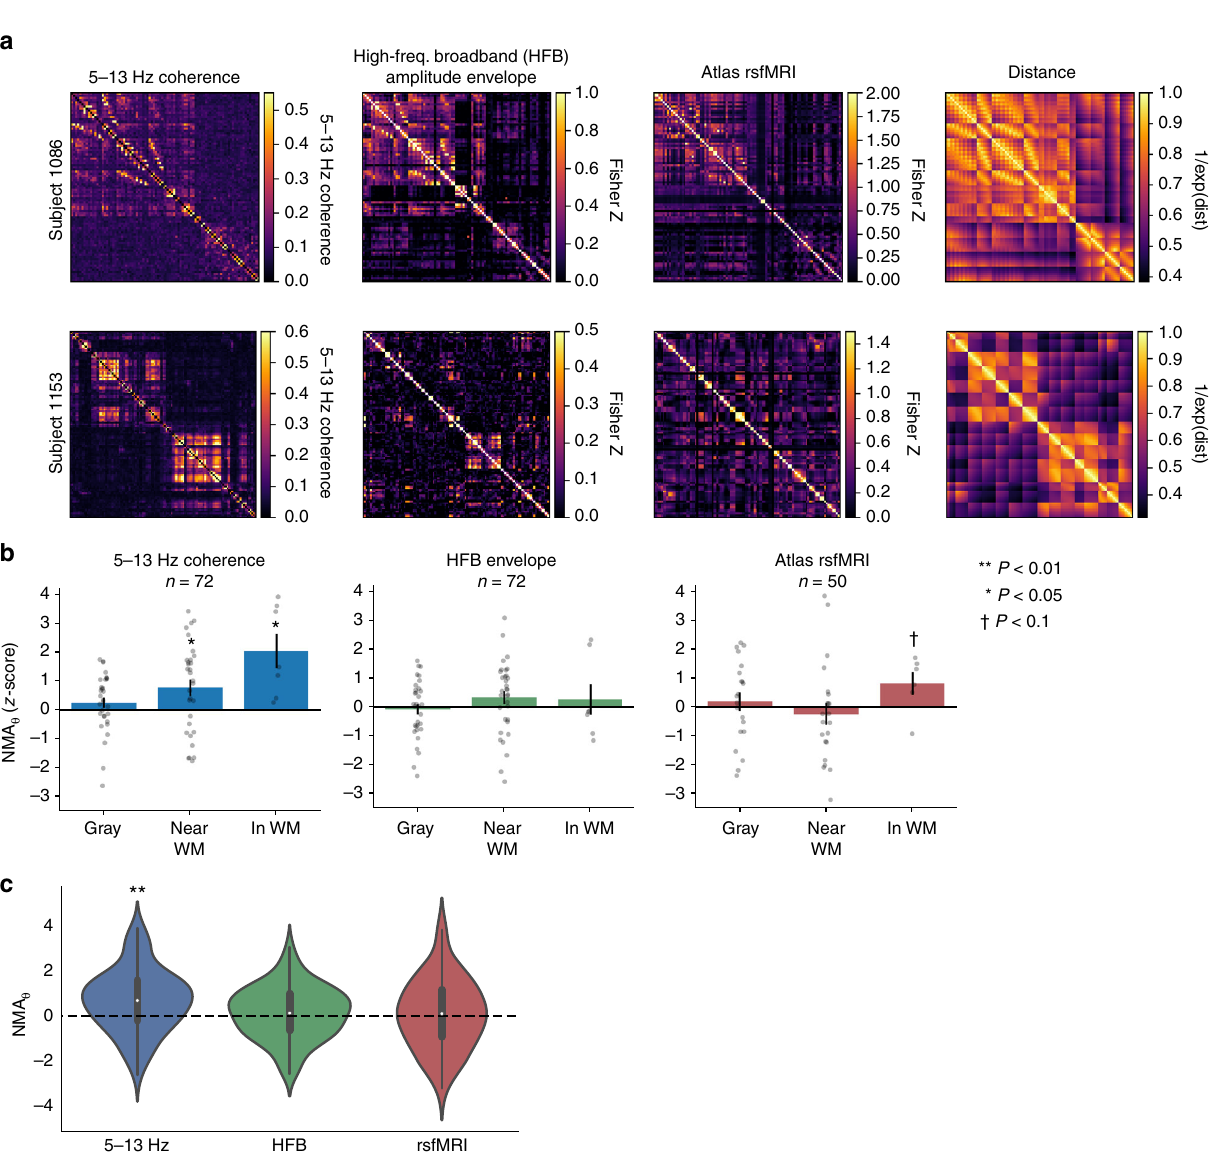
the expected false positive rate (binomial test, FDR-corrected P = 0.009; Fig. 7b).